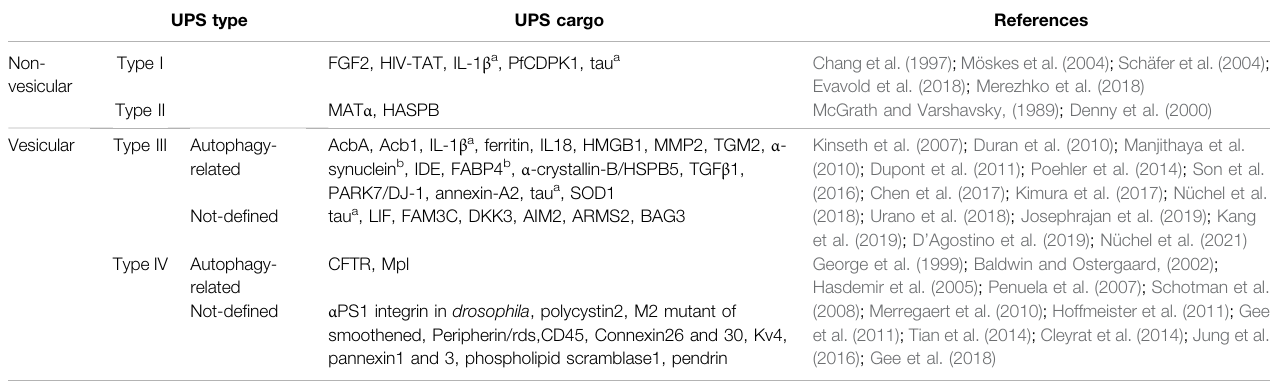
TABLE 1 | Autophagy-dependency of UPS cargo